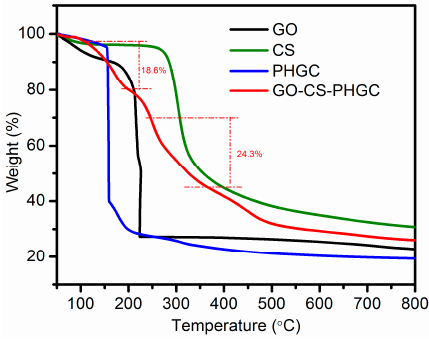
Figure 7. TGA curve of GO and GO-CS-PHGC.